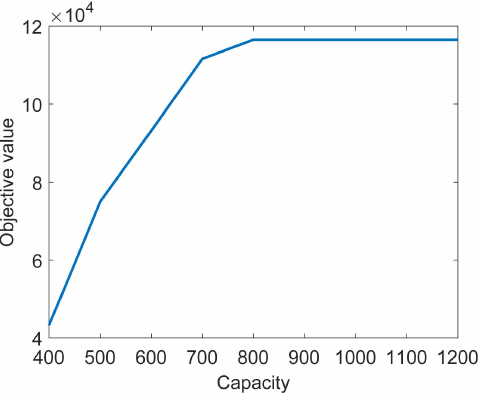
Figure 8. Variation curve of the objective function with different passenger service capacities.